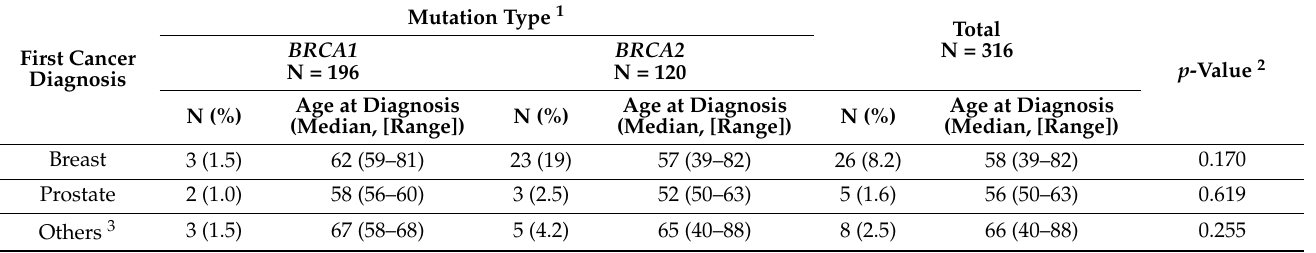
Table 4. Age at first cancer diagnosis according to cancer site and mutation